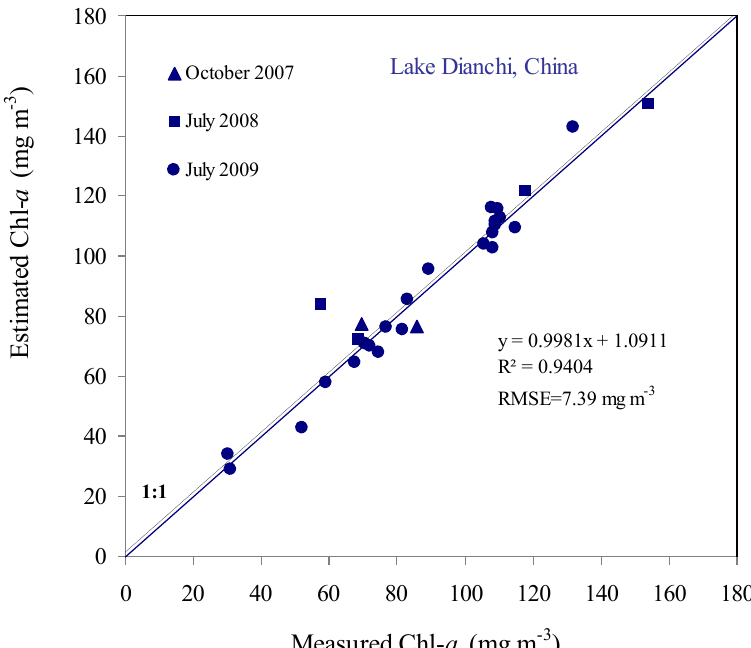
Figure 3. Comparison of the measured and estimated Chl- a by the SAMO-LUT for Lake Dianchi,